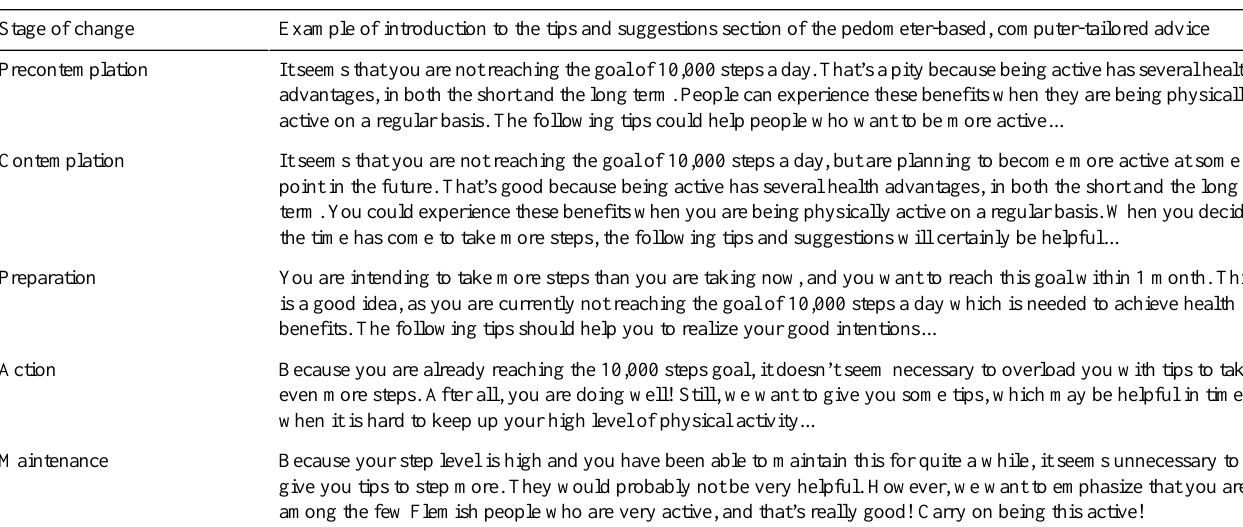
Table 1. Examples of introductions to the tips and suggestions of the advice intervention for the various stages of